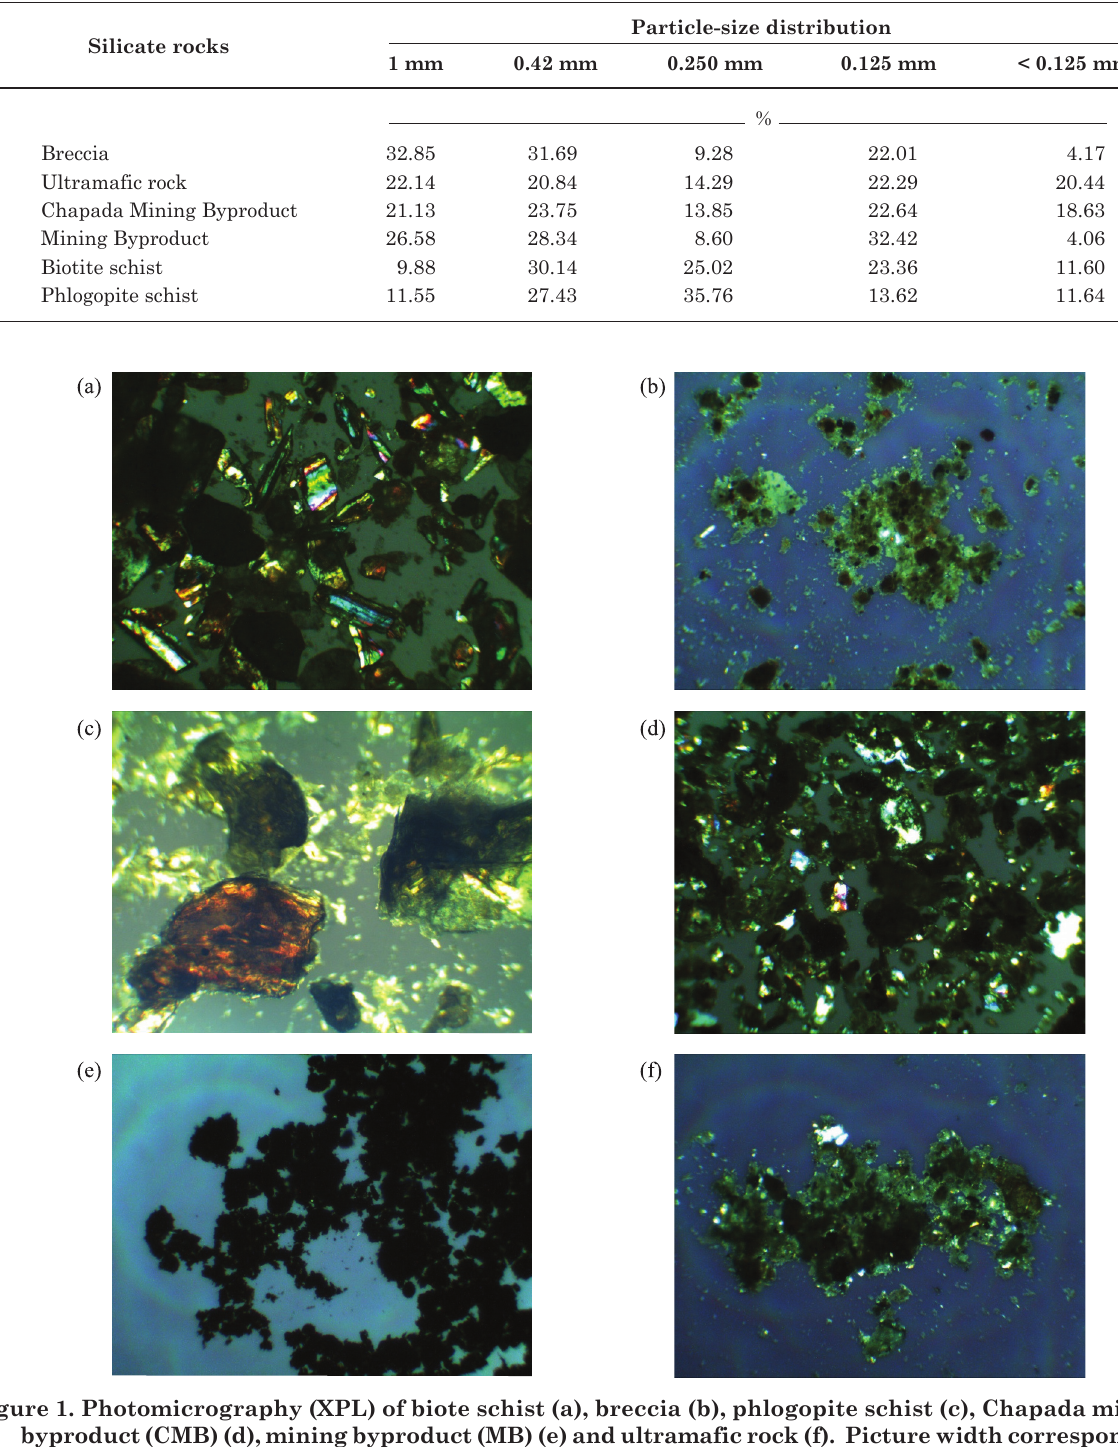
table 2. granulometry of ground rocks and mining wastes used in the experiment